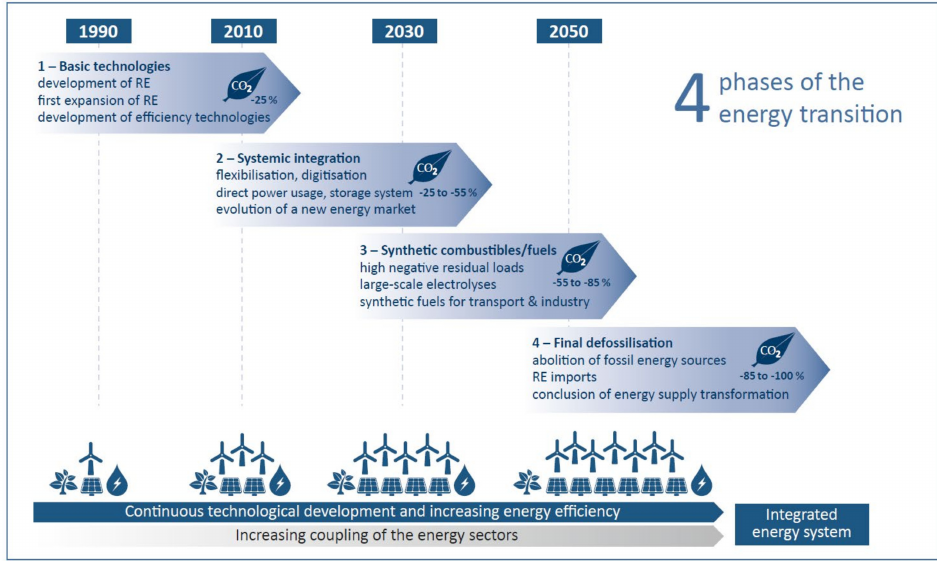
Figure 1. Timeline of the four-energy transition phases [3]. Germany’s power mix generated 485 g of CO 2 /kWh in 2017 [5], and with this current value, synthetic fuels will contribute to reaching the climate goals only in the long-term future. On the other hand, if synthetic fuels are produced with the curtailed surplus of renewable energy, the current carbon cycle can be balanced